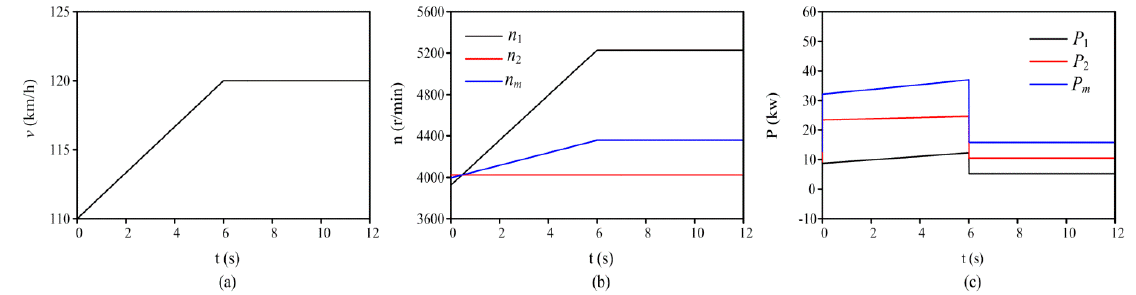
Figure 8. Mode 3: ( a ) Required vehicle velocity; ( b ) Rotational speeds; ( c ) Powers.